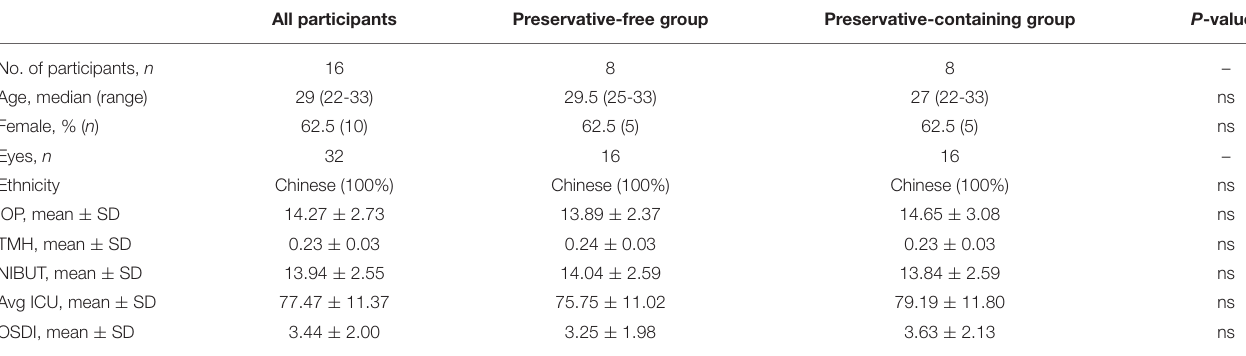
TABLE 1 | Demographic and clinical characteristics of the cohort. All participants